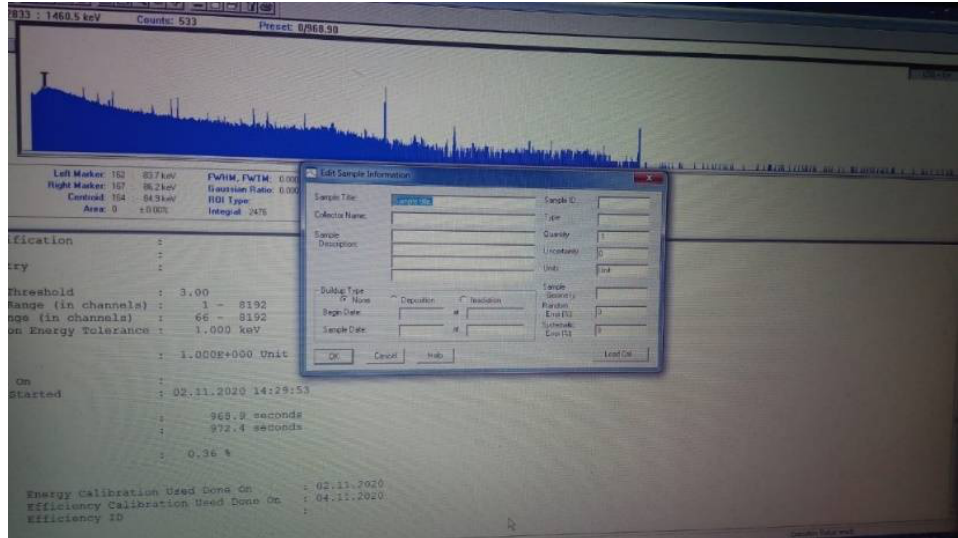
Figure 26. Gamma radiation measurement with a Canberra dosimeter and spectrometer. The recorded values were part of the background of natural radiation. The values that stood out were specific to potassium. The purpose of data collection was to demonstrate the robot's ability to perform different missions.